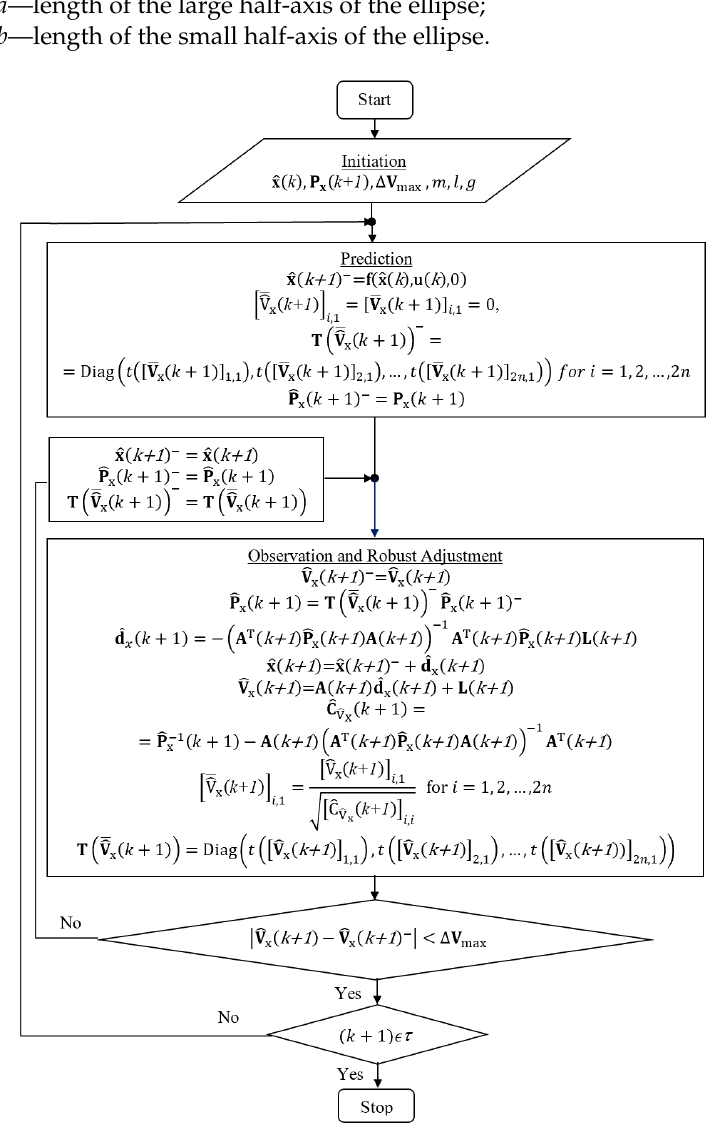
Figure 3. Algorithm for state vector estimation (cid:98) x ( k + 1 ) using geodetic adjustment with Danish gross error suppression